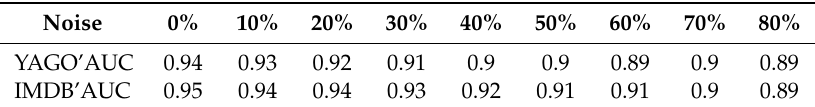
Table 2. T he Area Under the Receiver Operating Characteristic (ROC) Curve (AUC) of Kgedl with di ff erent scale of noise